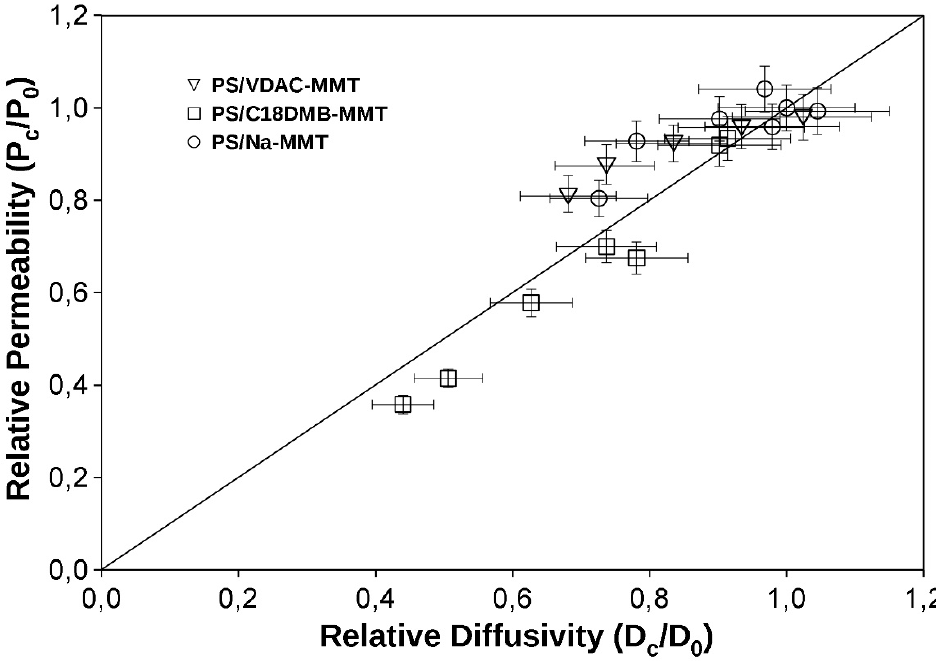
Figure 7. Relationship between relative permeability P c /P 0 and relative diffusivity D c /D 0 plotted for all studied composite materials [113].